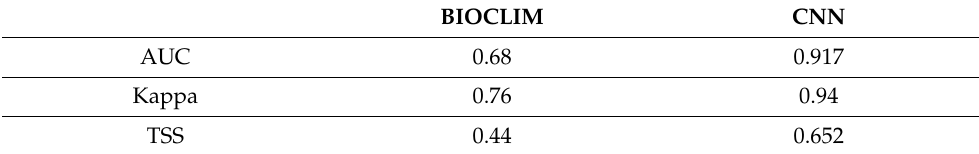
Figure 7. Probability distribution of Rhododendron arboreum using ( a ) BIOCLIM and ( b ) CNN Models. Table 2. Statistical performance analysis of BIOCLIM and